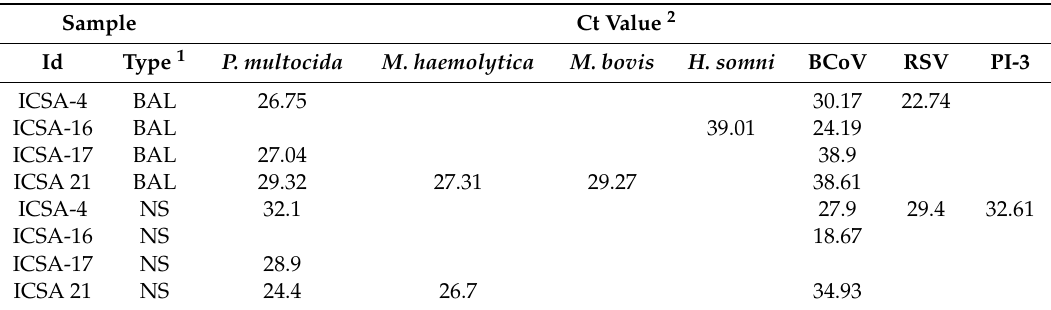
Table 1. Presence of co-infecting pathogens in bronchoalveolar lavages (BAL) or nasal swabs (NS) pools as determined by real time using the vetmax screening